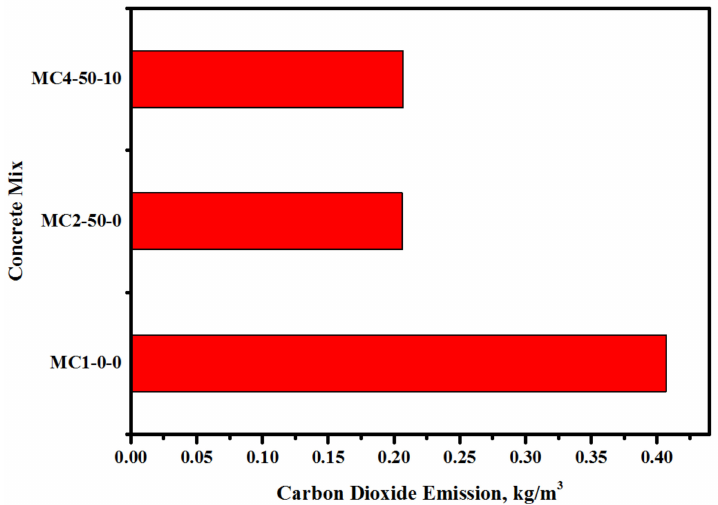
Figure 15. Effect of FA and EM content on CO 2 emission of the modified